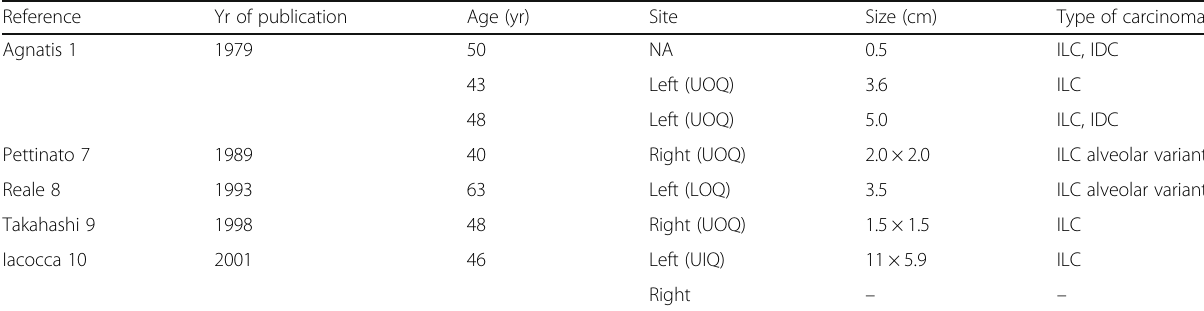
Table 1 Summary 7: published cases of invasive lobular carcinoma of the breast with Osteoclast-like giant cells